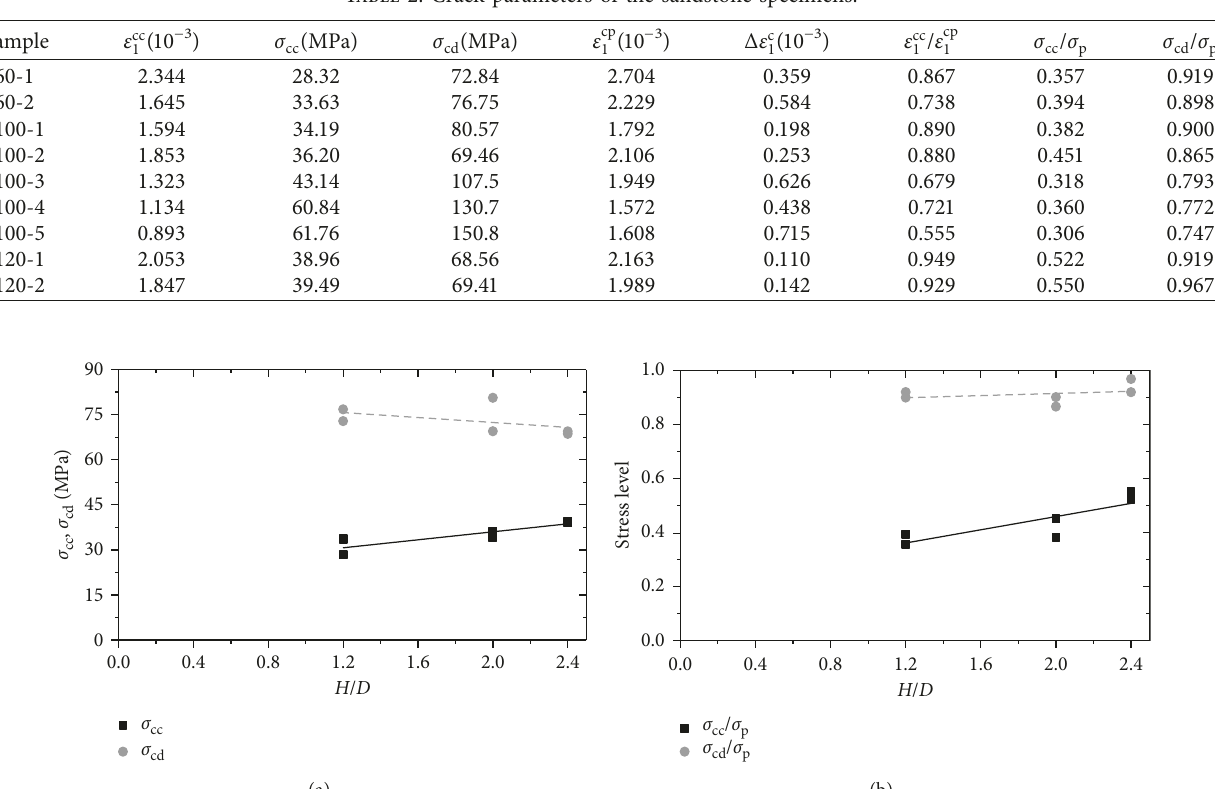
Figure 4: The relationship between the crack axial strain and the axial stress: (a) data from the sandstone specimen S100-1; (b) data from the sandstone specimen S100-3. Table 2: Crack parameters of the sandstone specimens.